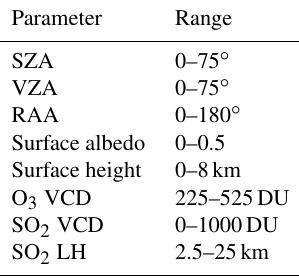
Table 1. Physical parameters varied for the generation of re- flectance spectra. The optimized parameter range for training the final FP_ILM retrieval operator is shown. (SZA: solar zenith angle; VZA: viewing zenith angle; RAA: relative azimuth angle; VCD: vertical column density; LH: layer height.) Parameter